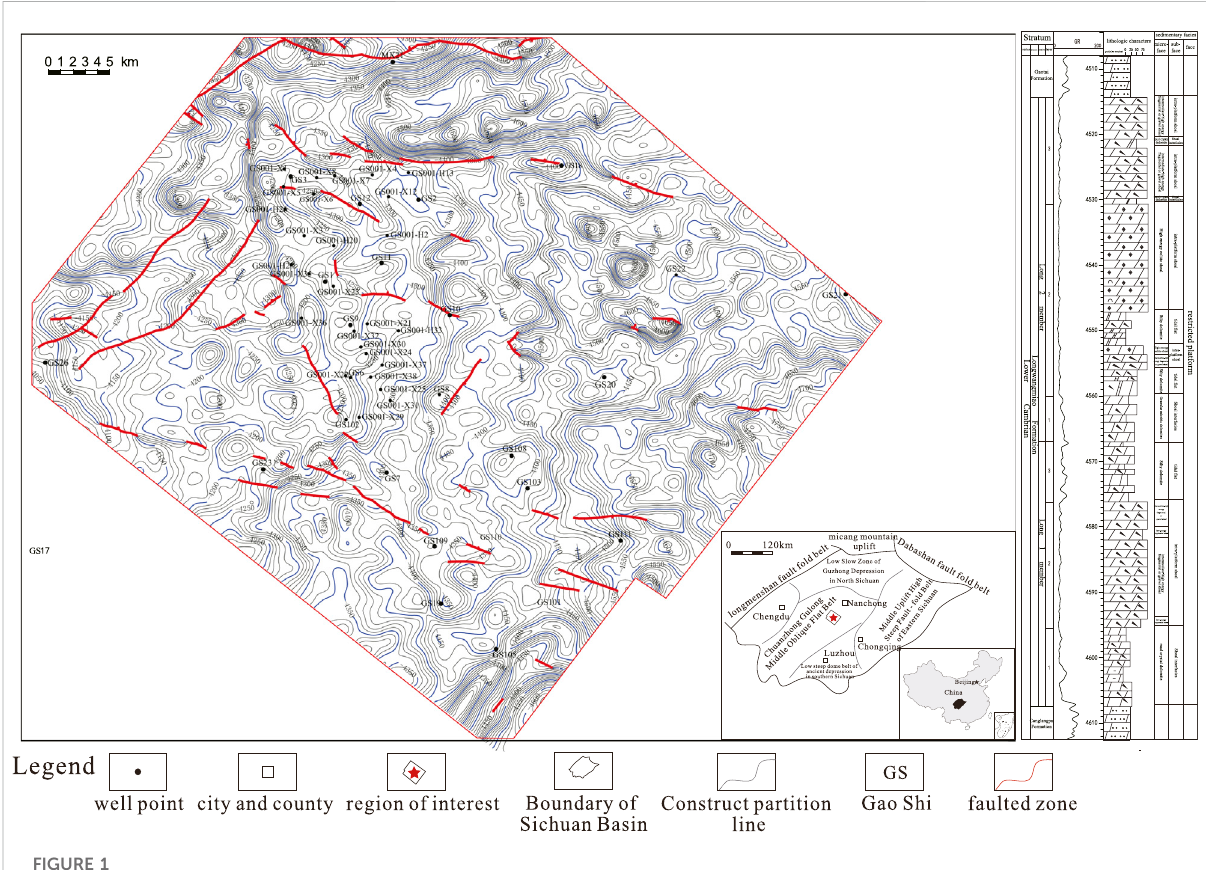
FIGURE 1 Location, structure, well distribution and division of stratigraphic units in the study